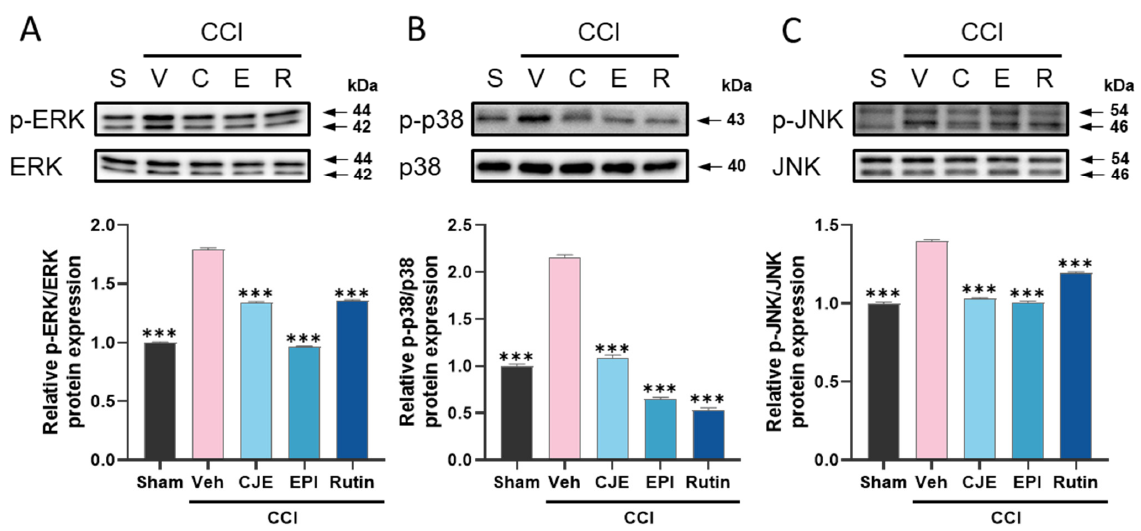
Figure 4. Effect of oral administration of CJE, ( − )-epicatechin, and rutin on the mitogen-activated protein kinases (MAPKs) signaling pathway in the dorsal root ganglion (DRG) in chronic constriction injury model. ( A – C ) Representative Western blots and quantitative Western blot analysis of MAPKs expression were performed in L4–L5 DRG tissues. Representative Western blots and quantitative analysis of the protein levels of phosphorylated extracellular signal-regulated kinase (ERK)1/2 ( A ), p38 ( B ), and c-Jun N-terminal kinase (JNK) ( C ) in the DRG. Data are presented as the mean ± SEM of three independent experiments and analyzed using one-way ANOVA; *** p < 0.001 compared with CCI with the vehicle treatment group.